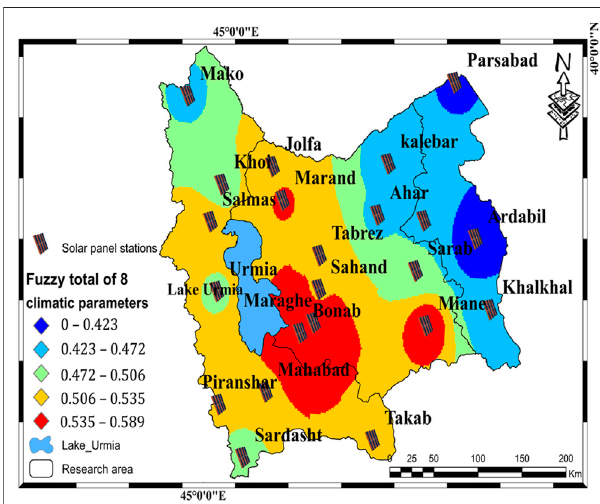
FIGURE5| Finalzoningoftheparameters affectingtheestablishmentof the thermal solar power-house, Source: Authors.